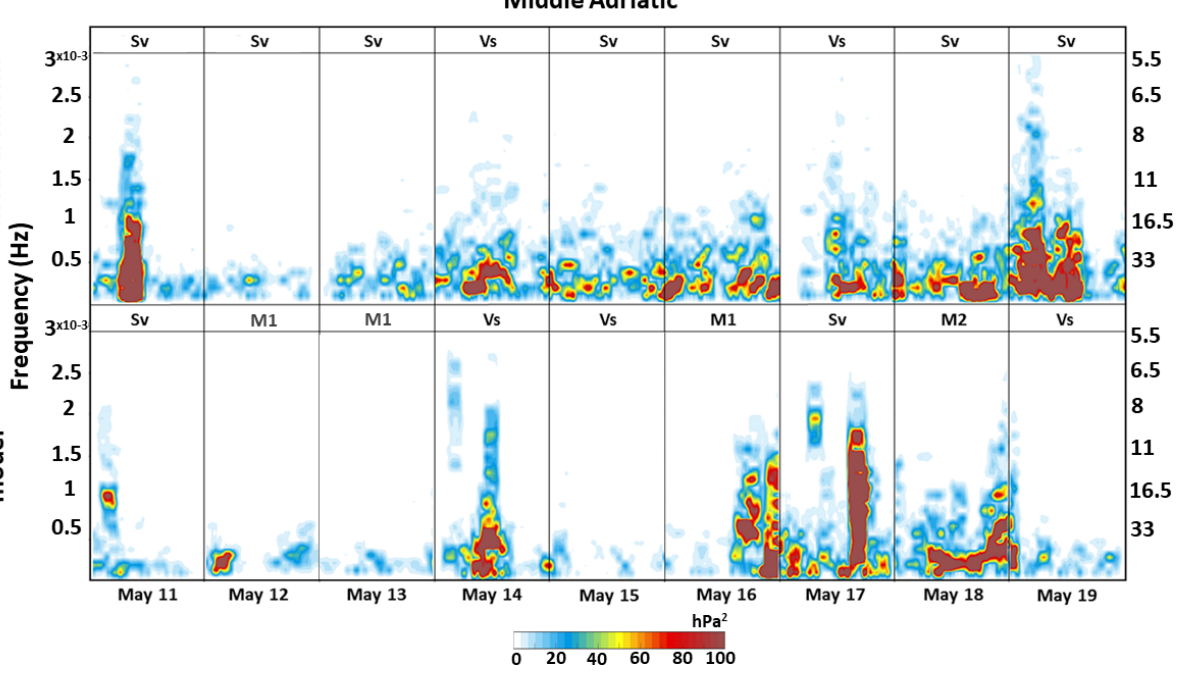
Figure 5. As in Fig. 4, but for the middle Adriatic